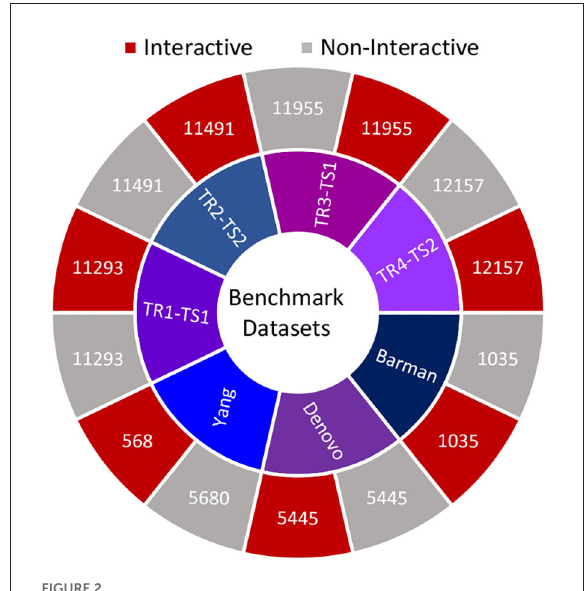
FIGURE2 Summary statistics of 7 datasets utilized in this study. For each study, the respective number of positive and negative samples are